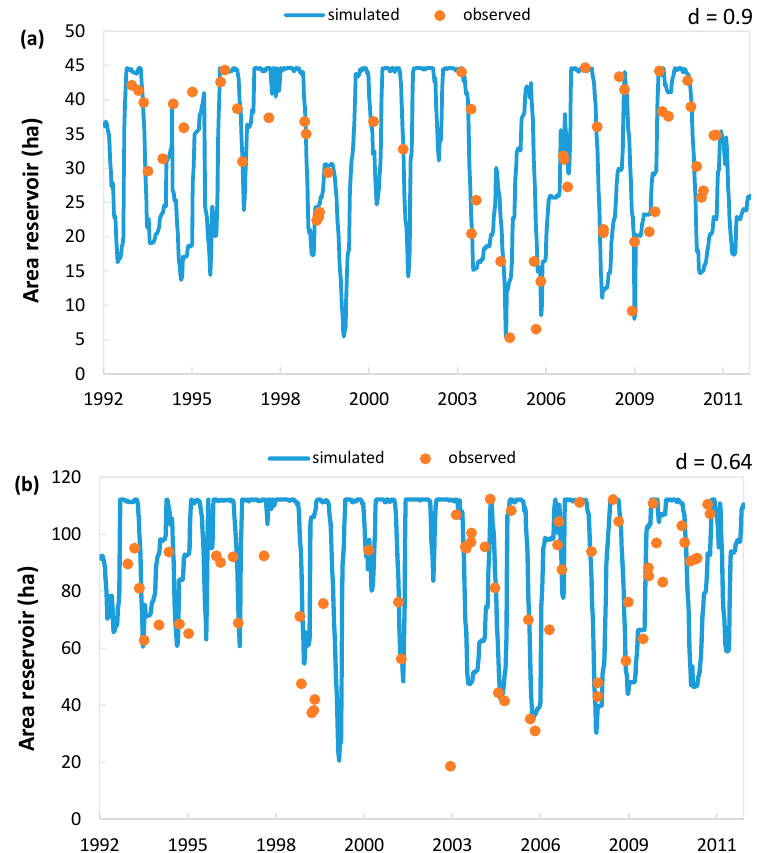
Figure 8. Comparison between the simulated reservoir area (blue line) and the observed one (orange dots) obtained from satellite images, for two reservoirs (( a ) lat = − 30.018, long = − 56.526; and ( b ) lat = − 30.044, long = − 56.549).